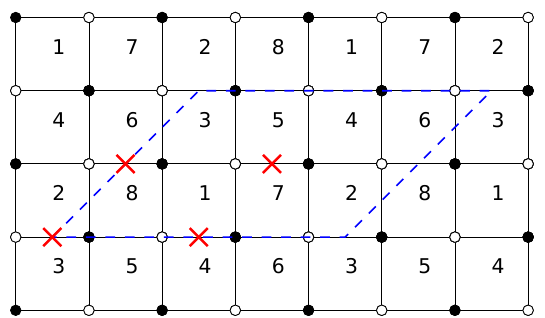
Figure 10 . PdP 5 dimer with orientifold